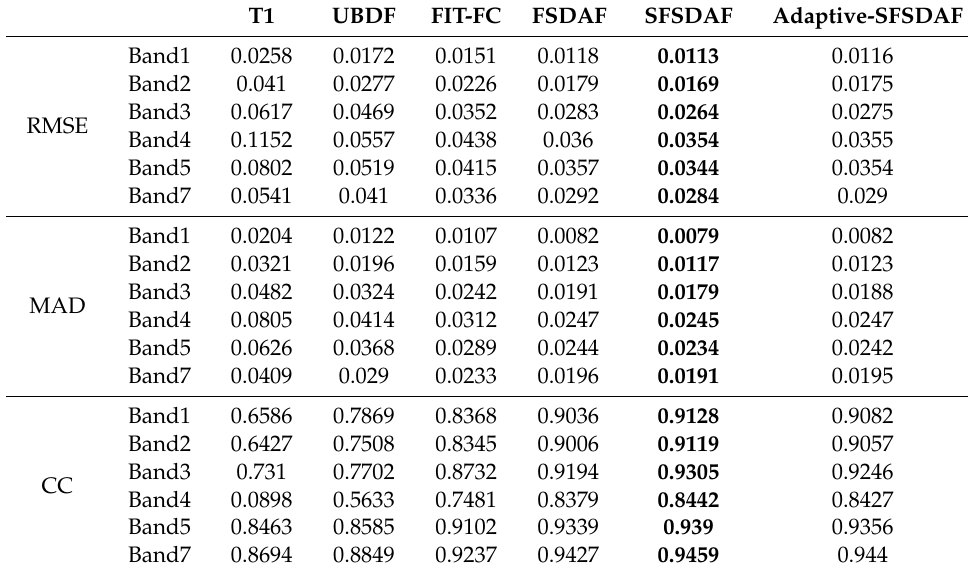
Table 1. Accuracy Assessment of the Five Fusion Methods at the Coleambally Site in Figure 3. Bold data indicate the most accurate